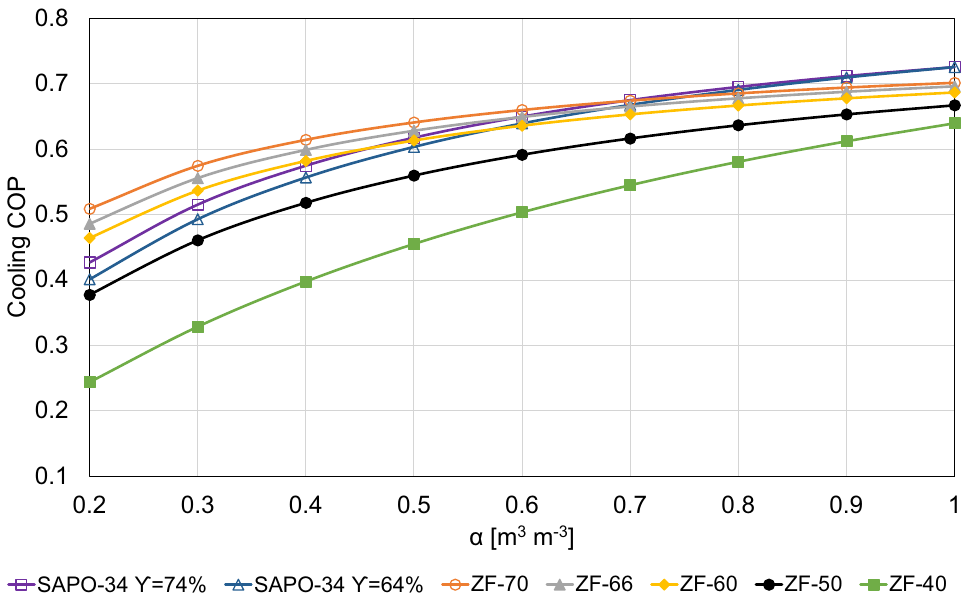
Fig. 12 Cooling COP as a function of the ratio between available volume and overall volume of the HEX, calculated for two loose grains and composite foams